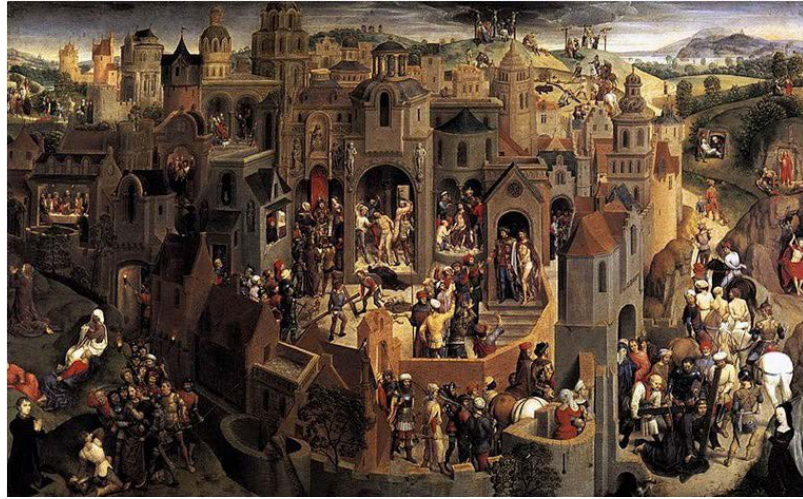
Figure 30 – Hans Memling, Passione di Cristo , Torino, Galleria Sabauda, Public Domain,